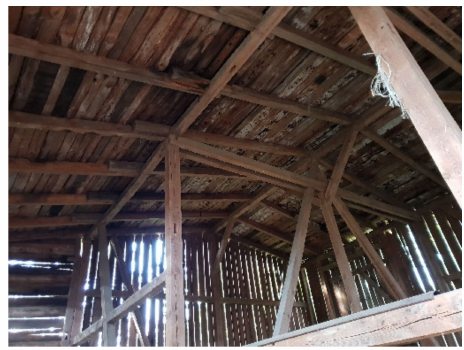
Figure 11. View of the bearing structure.